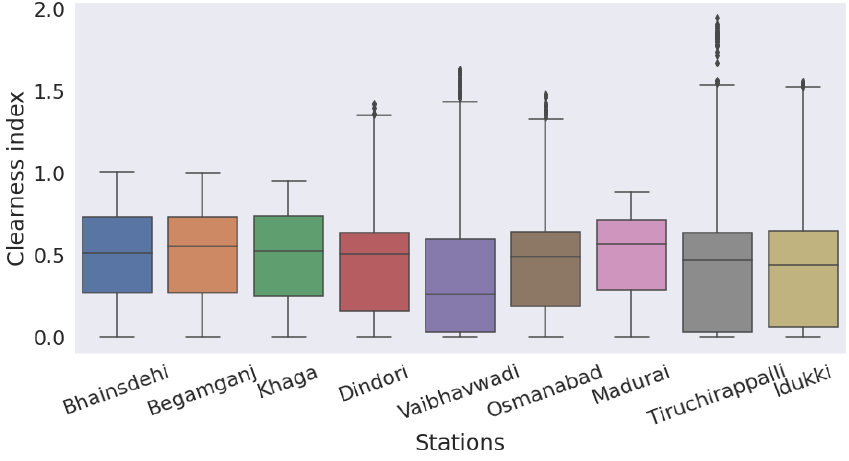
Figure 9. Average value and variability of clearness index of forecasting sites.